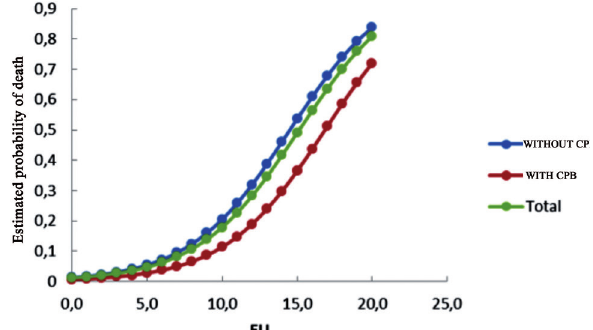
Fig. 5 - Model for the 2000 Bernstein logistic Parsonnet (2000BP) showing the probability of death overall, and for each of the groups with and without cardiopulmonary bypass for patients undergoing coronary artery bypass grafting